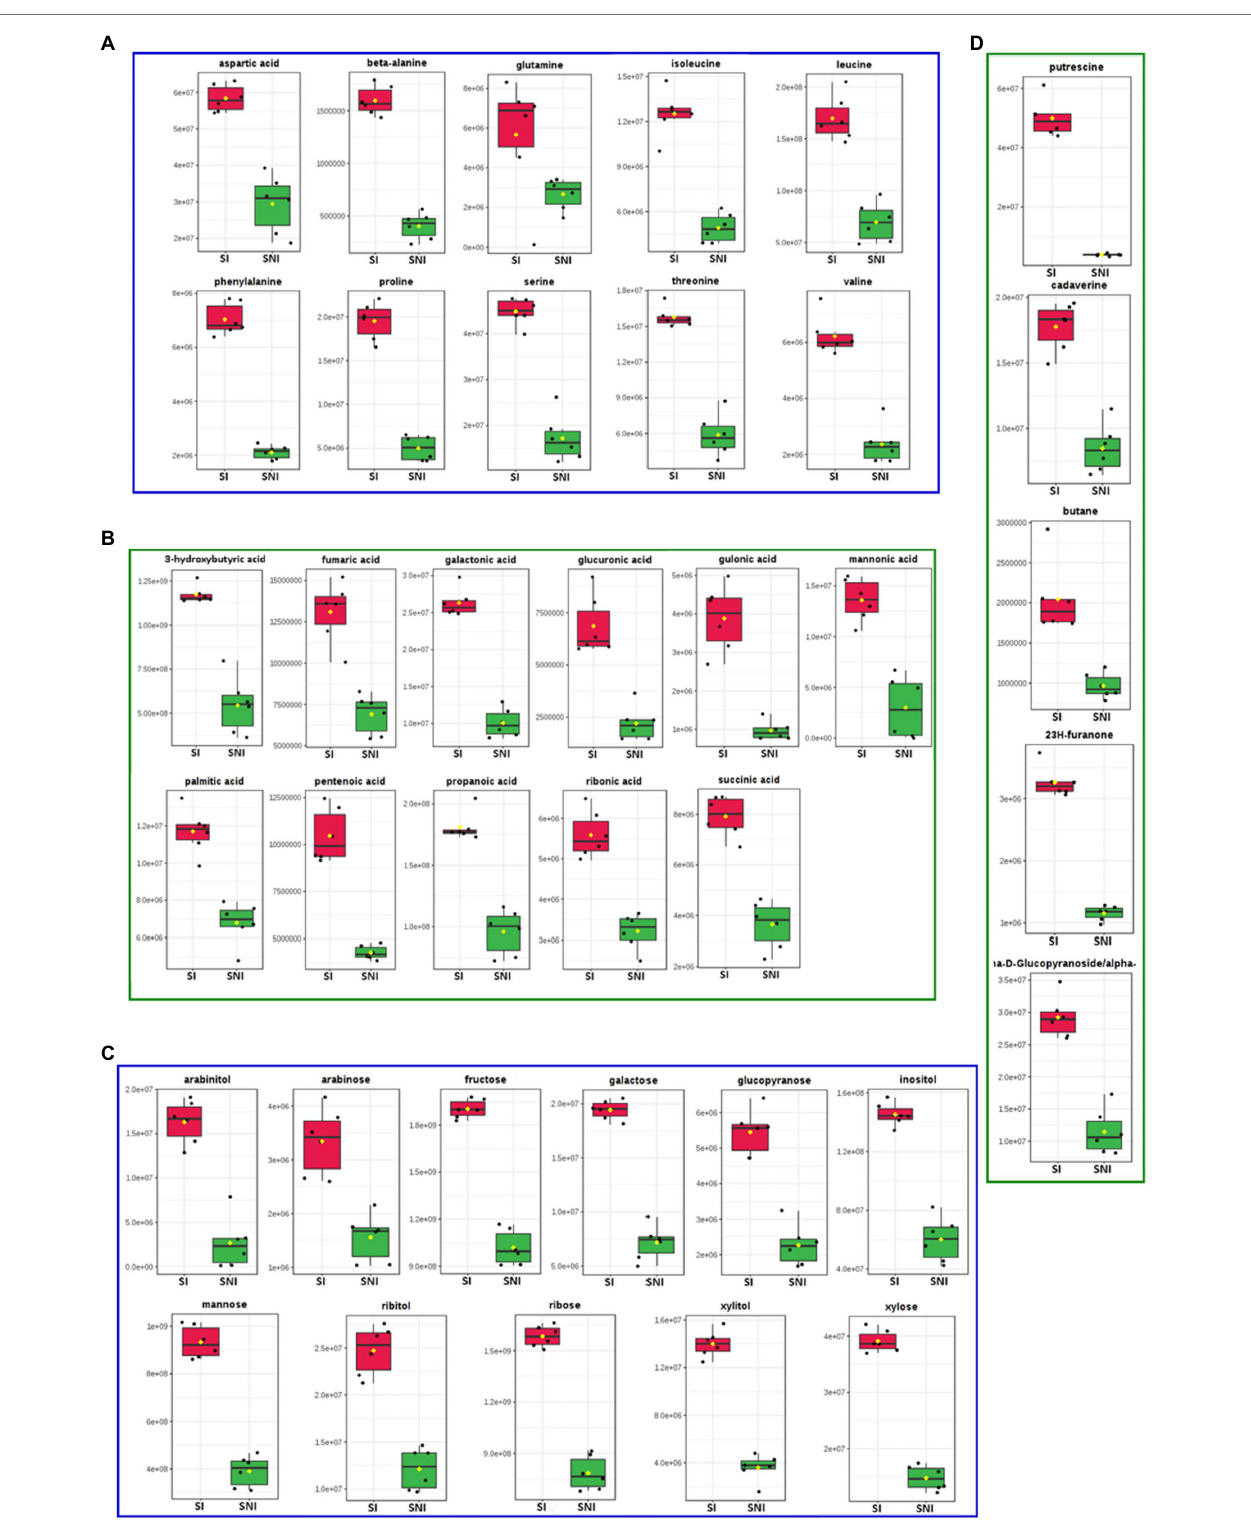
FIGURE 4 | The significantly enriched metabolites of susceptible tobacco cultivar Yunyan87 in response to R. pseudosolanacearum infection. (A) Enriched amino acids. (B) Enhanced organic acids. (C) Sugar and polyols compounds enriched. (D) Other enriched compounds after R. pseudosolanacearum infection. The red indicates the quantification peak area of metabolites from xylem sap of susceptible tobacco cultivar Yunyan87 infected with R. pseudosolanacearum , and green indicates quantification peak area of metabolites from xylem sap of healthy tobacco cultivar Yunyan87